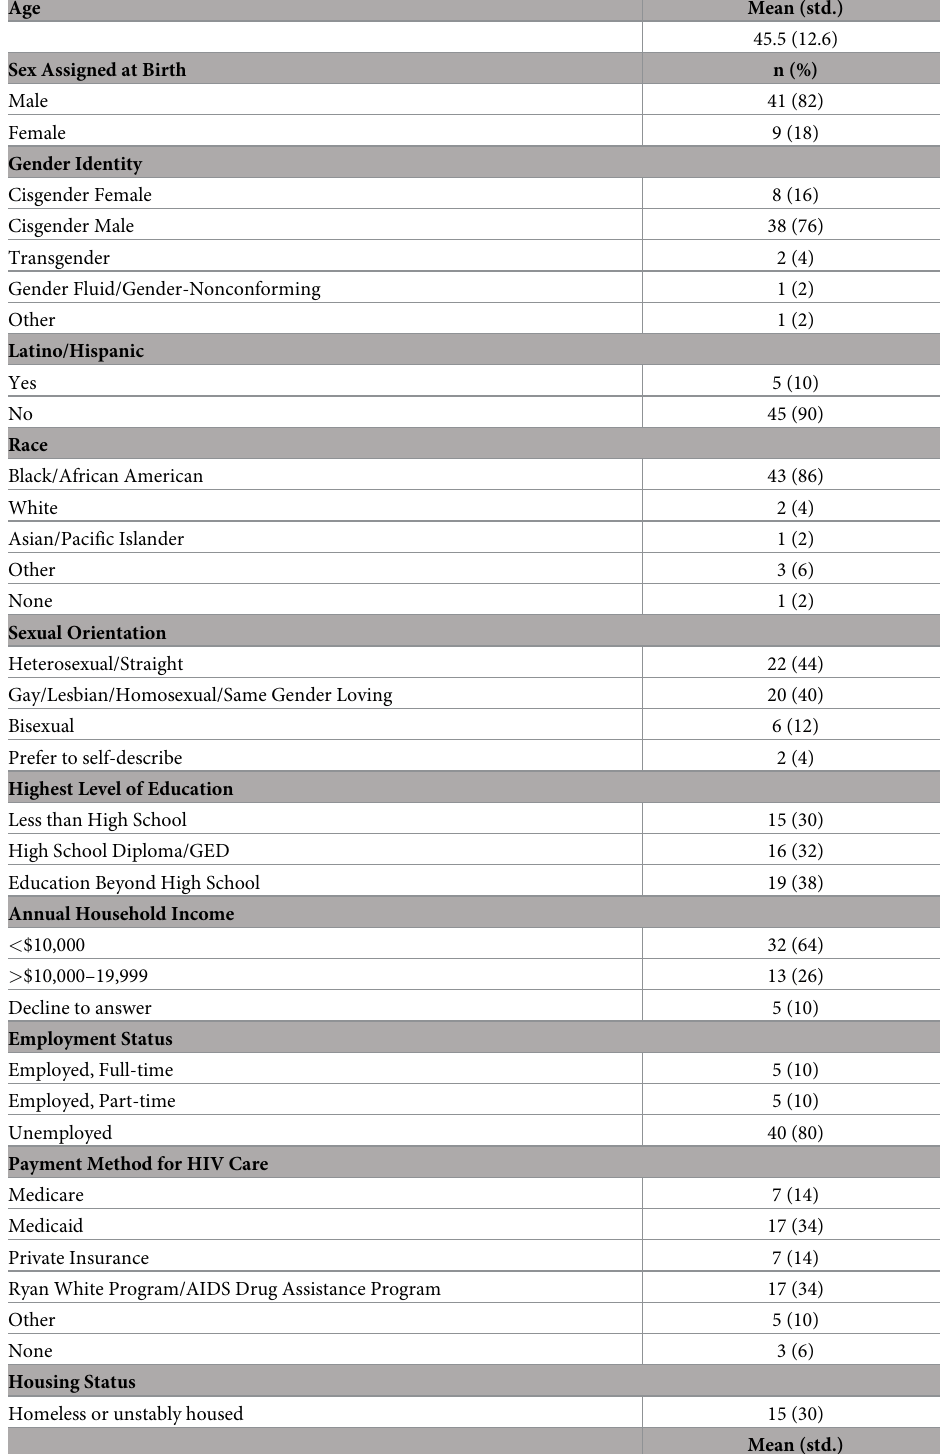
Table 1. Population and demographic characteristics of survey participants (out-of-care people living with HIV; n = 50). Age Mean